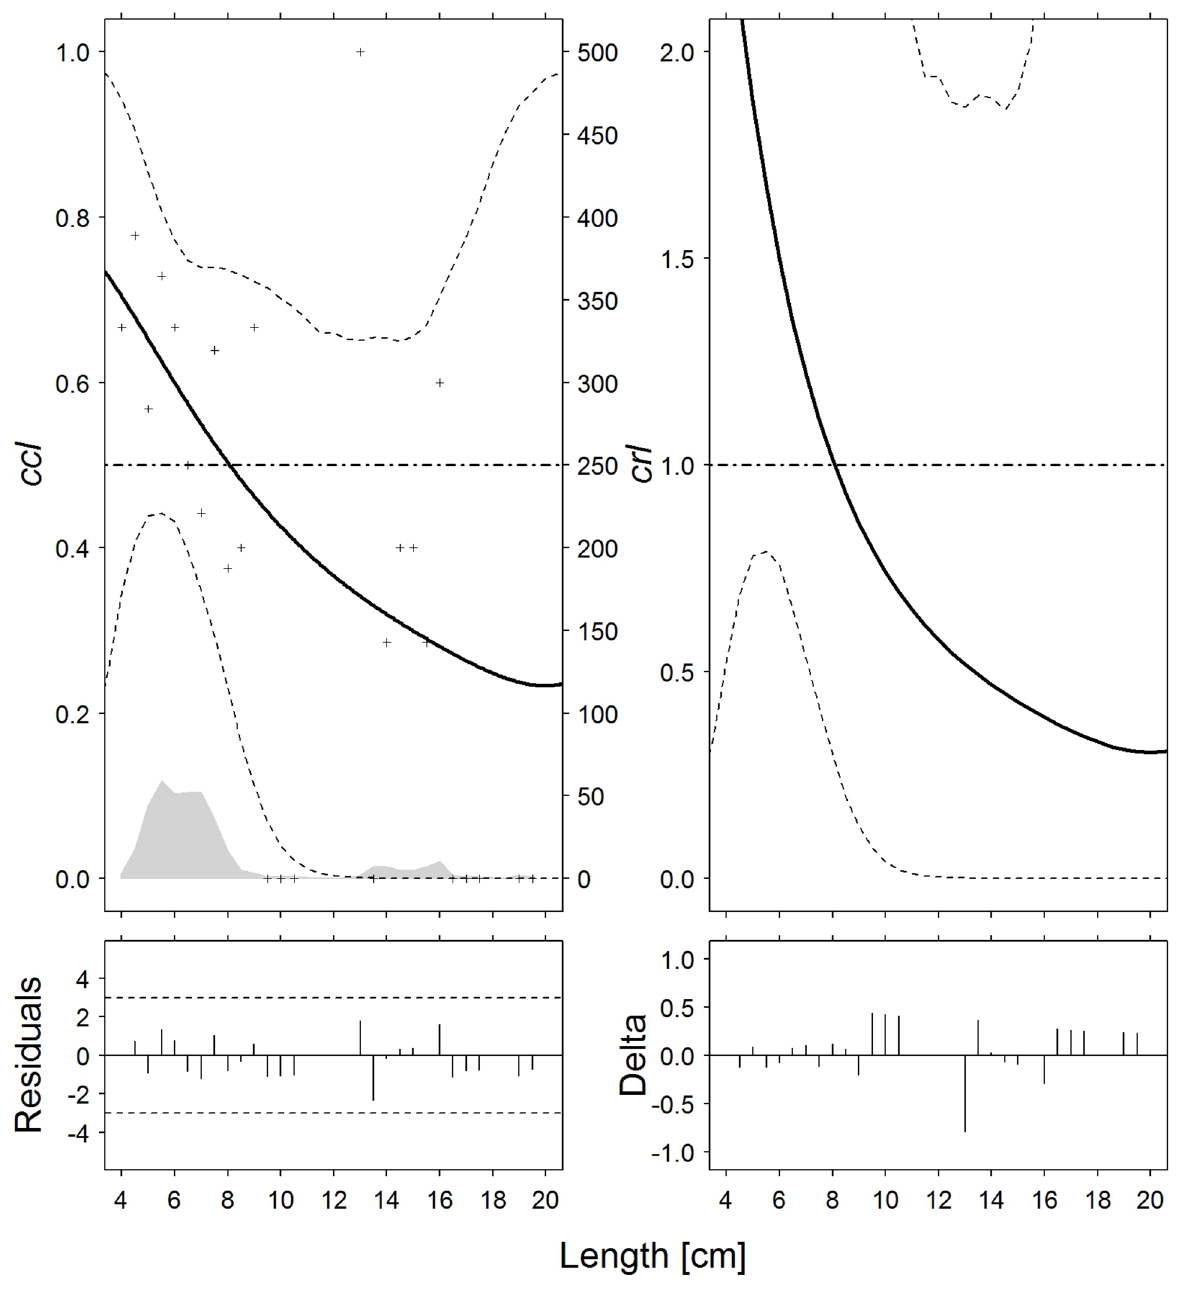
Fig 5. Poor cod ( T . minutus ). Catch comparison rates ( cc , top left )and catch ratio curves ( cr , top right ) of the 30-minute and 60-minute tows ℓ ℓ (solid curves). Crosses: experimental rates; thin dotted curves: 95% confidence intervals; grey solid curve: summed and raised catch populations for all hauls; horizontal dashed line: baseline of no effect on catch performance after changing tow duration. Partial residual plots ( bottom left ) and delta dispersion ( bottom right ) for the two